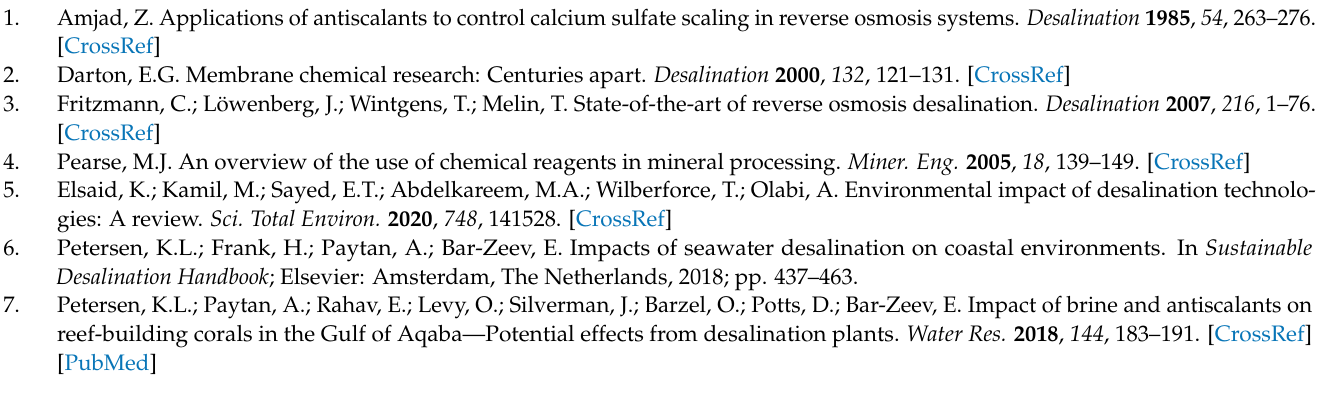
Figure S2: Phyla relative abundance in each treatment following different incubation periods. Shades of the same color represent the different bacterial order in each phylum; Figure S3: DOC degradation kinetics of 100 mg/L polyacrylic acid- (CA) and carboxylated den-drimeric- (DN) based antiscalants. Figure S4: Phyla relative abundance in each treatment following different incubation periods. Shades of the same color represent the different bacterial order in each phylum. Table S1: A number of high- quality sequences, Good’s coverage, Chao1, and Shannon-Wiener index for all studied treatment and different time points; Table S2: Adonis significance based on Bray-Curtis distance matrix; Table S3: ANOVA analysis of Adjusted R2 for RDA analysis showing different variables and chemical analysis significance and percent of the